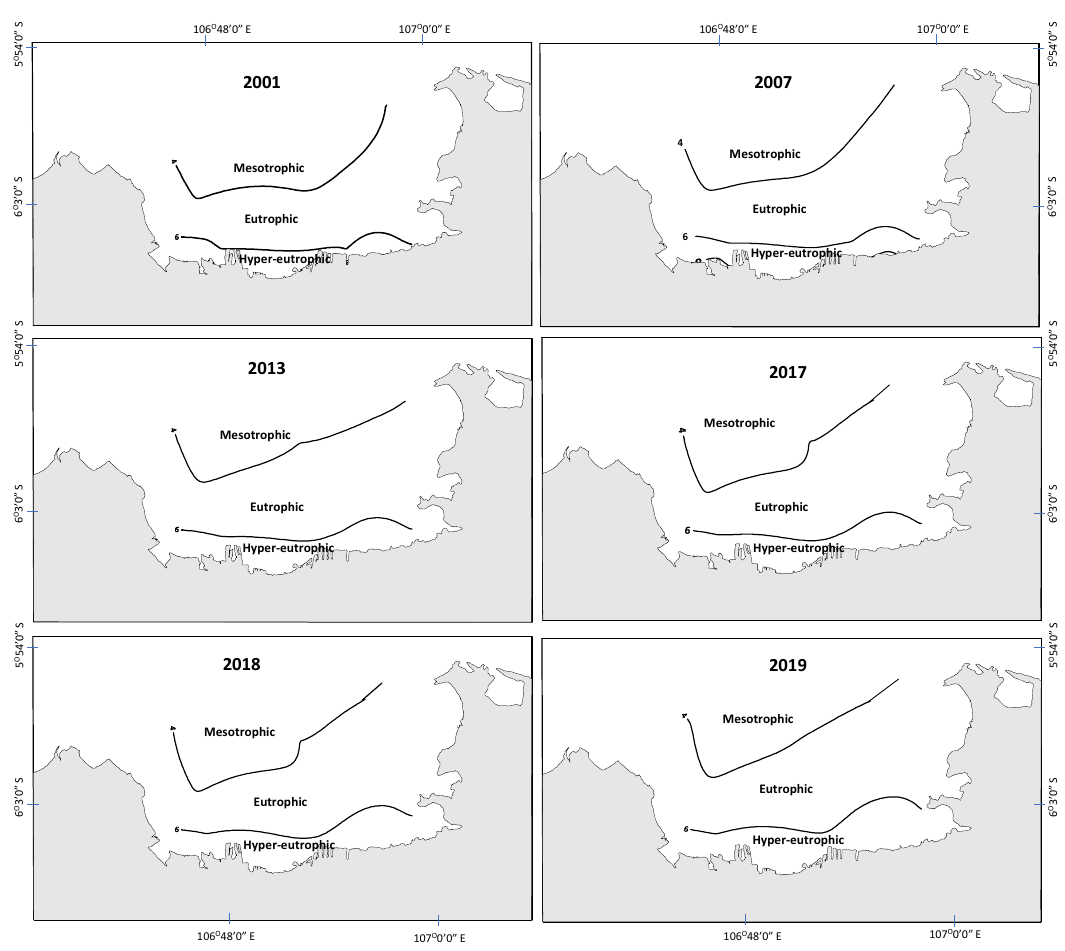
Figure 9. Spatial distribution of eutrophication levels in Jakarta Bay, 2001–2019. Table 3. Temporal change in the area (km 2 ) of each eutrophication status in Jakarta Bay, 2001–2019. Eutrophication